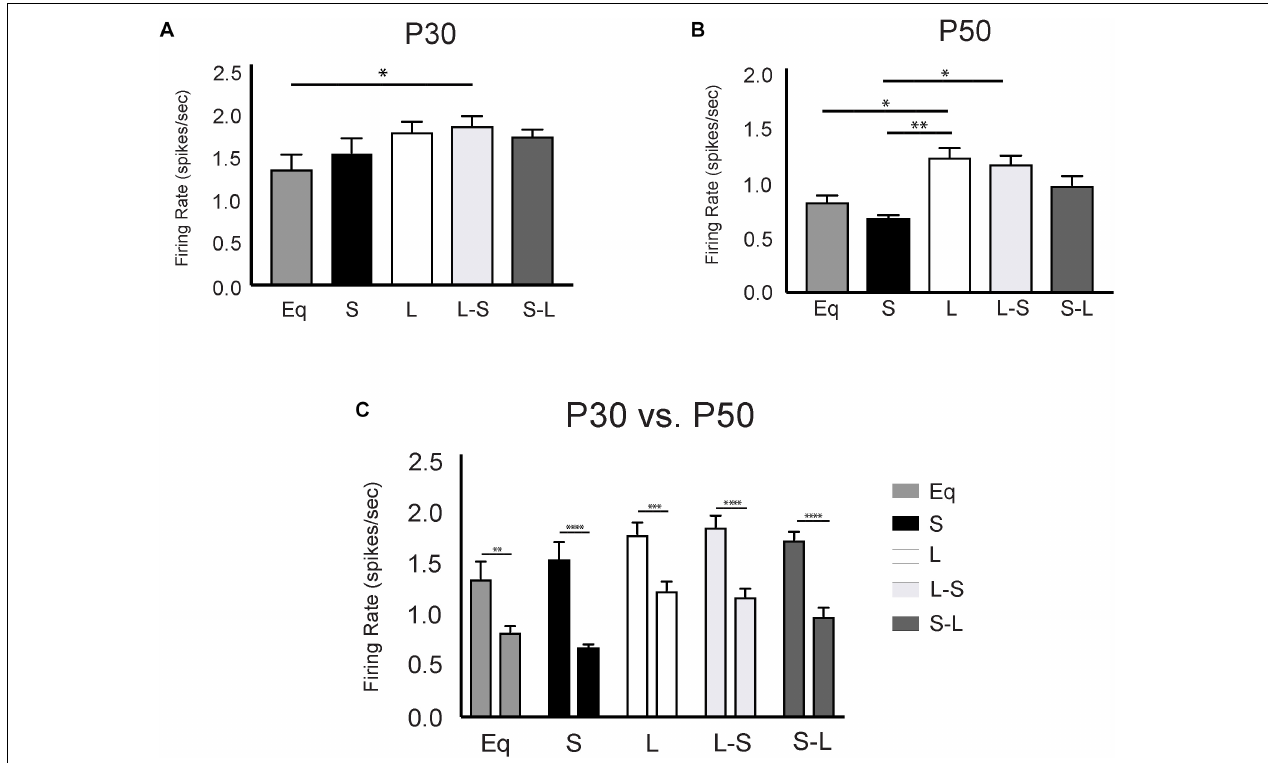
FIGURE 2 | Long prenatal photoperiod programs lasting changes in firing rate of dorsal raphe serotonin (5-HT) neurons. (A) Analysis of 5-HT neuronal firing rate across photoperiods at P30, (B) at P50 and (C) within photoperiods during the P30 and P50 time points. Eq, equinox photoperiod; S, short photoperiod; L, long photoperiod; L-S, animals switched from a Long to Short photoperiod at birth and S-L represents animals switched from a Short to Long photoperiod at birth. The significant levels are as follows: ( ∗ p < 0.05, ∗∗ p < 0.01, ∗∗∗ p < 0.001, ∗∗∗∗ p < 0.0001) using Holm-Sidak’s multiple comparison tests. At P30 we observed DRN firing rates for the following groups: Eq = 1.36 Hz +/– 0.16, n = 4 mice, 35 cells; L = 1.79 Hz +/– 0.12, n = 6 mice, 59 cells; S = 1.54 Hz +/– 0.17, n = 6 mice; 84 cells; L-S = 1.86 Hz +/– 0.11, n = 6 mice, 80 cells; S-L = 1.74 Hz +/– 0.08, n = 5 mice, 112 cells. In addition, at the P50 time point 5-HT neuronal firing rates were observed as: Eq = 0.83Hz +/– 0.06, n = 6 mice, 92 cells; L = 1.24 +/– 0.096, n = 6 mice, 153 cells; S = 0.68 Hz +/– 0.04, n = 6 mice, 70 cells; L-S = 1.18 Hz +/– 0.08, n = 5 mice, 30 cells; and S-L = 0.99 Hz +/– 0.08, n = 7 mice, 57 cells. Data used for the Eq, S, and L groups at the P50 time point were previously published in Green et al., 2015 Curr